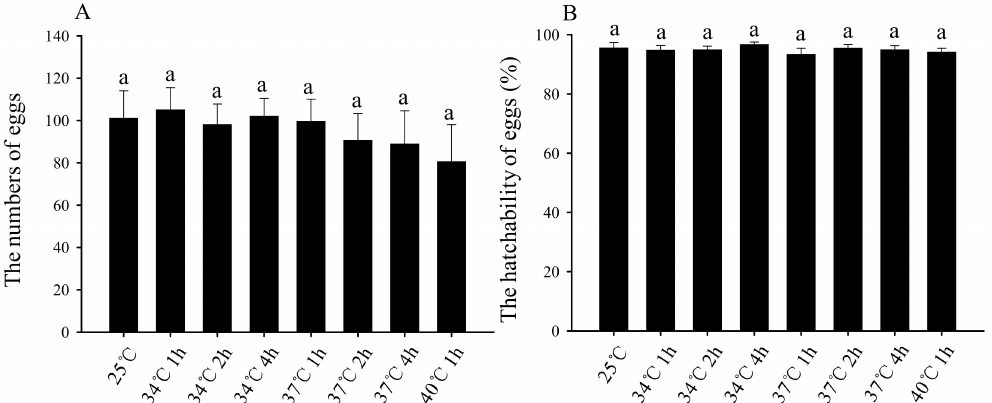
Figure 5. E ff ects of short-term high-temperature stress of third-instar larvae on oviposition amount ( A ) and hatchability ( B ) in subsequent Bradysia odoriphaga female adults. Male and female adults unmated were paired and placed in individual culture dishes ( Φ = 60 mm), with one pair per container, and six pairs as a replicate. The numbers of eggs and larvae were recorded. If some of the eggs in a culture dish had hatchability, the numbers of eggs in the culture dish were used for statistical analysis. Values are means ± SD of five replicates. Within each panel, bars with same letters are not significantly di ff erent according to Tukey’s test ( p >